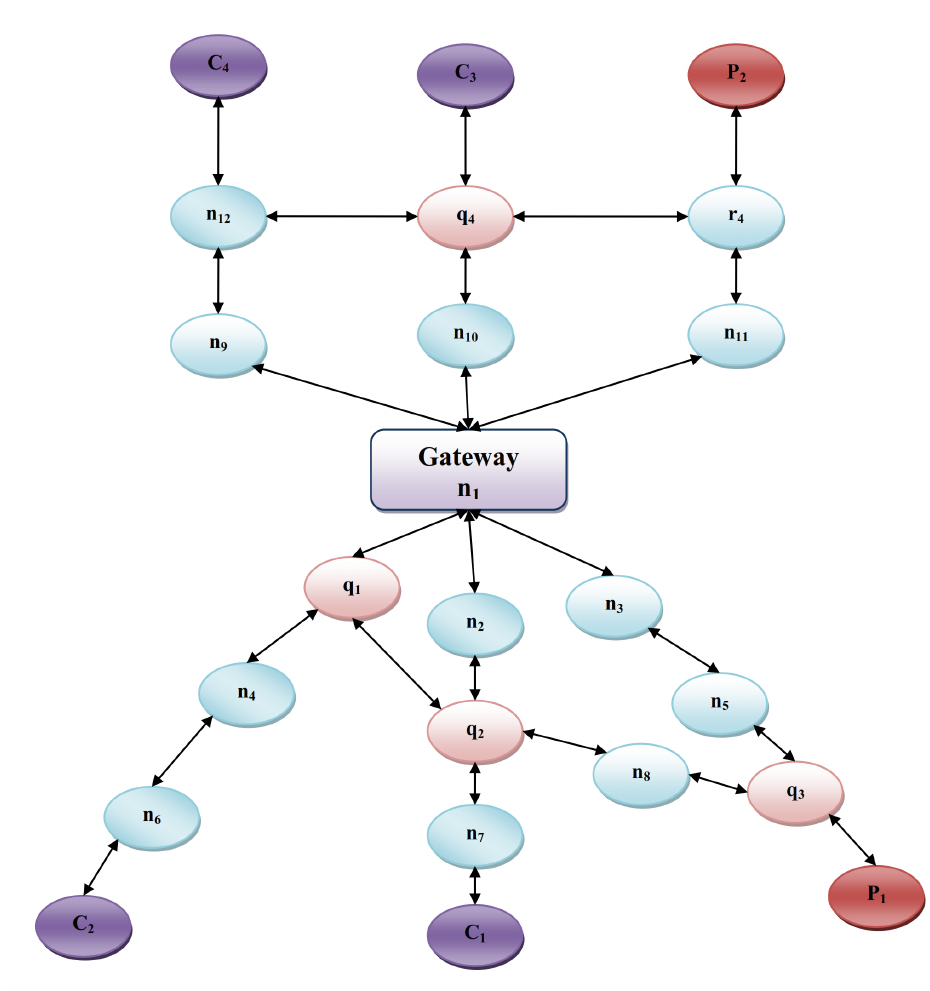
Figure 3. A representation of a path connecting content producers and consumers for